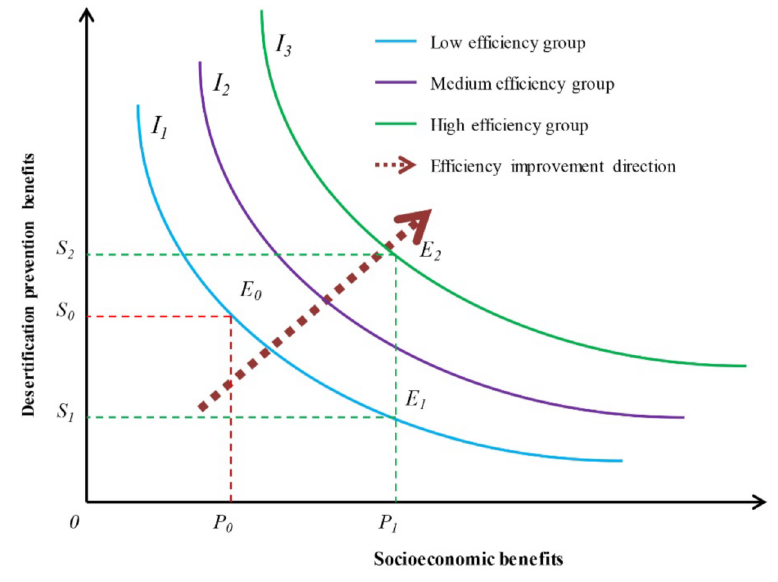
Figure 6. Decision process of residents. Different efficiency residents belong to different D–S curves. Low-efficiency group I 1 < medium-efficiency group I 2 < and high-efficiency group I 3